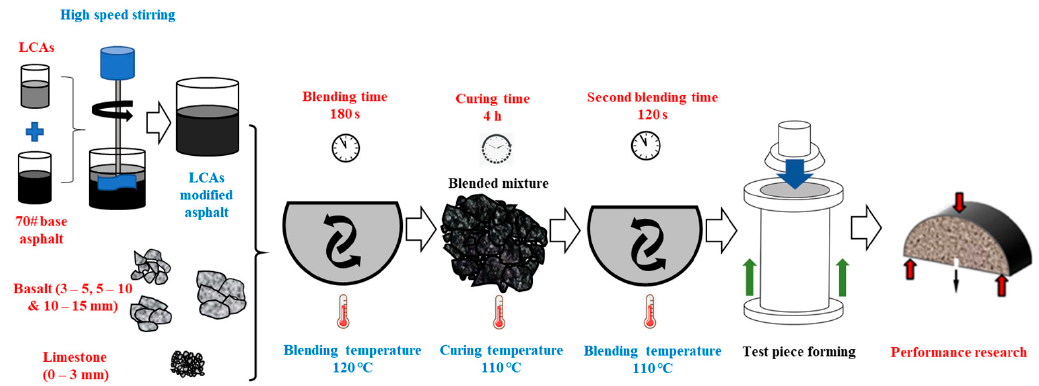
Figure 3. Preparation method of LAC-AMs.